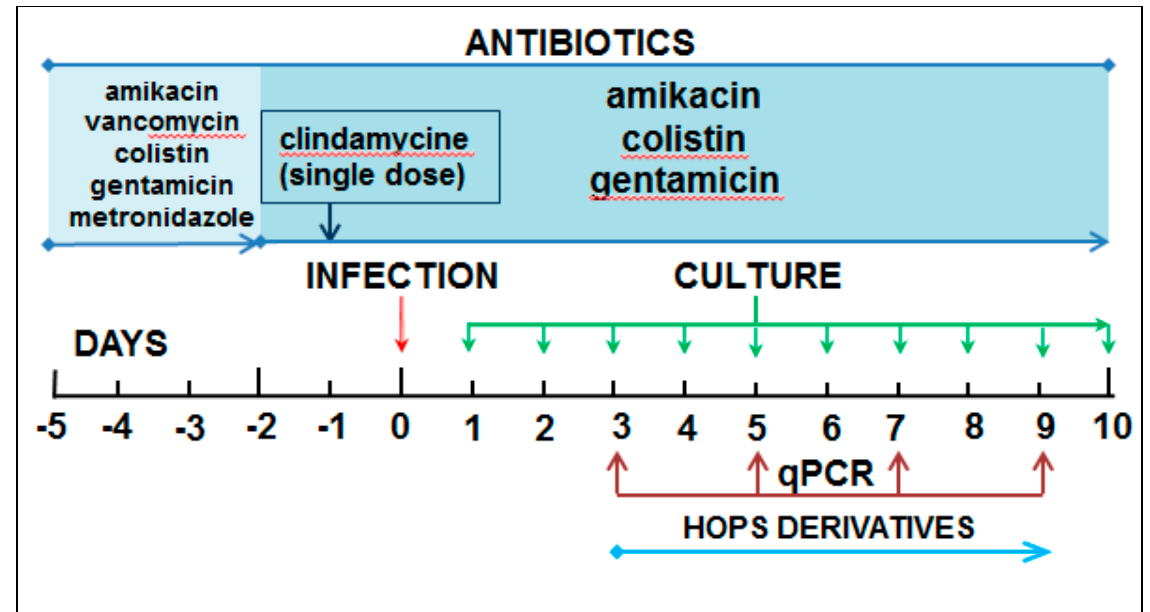
Figure 6. Time course of the experiment.